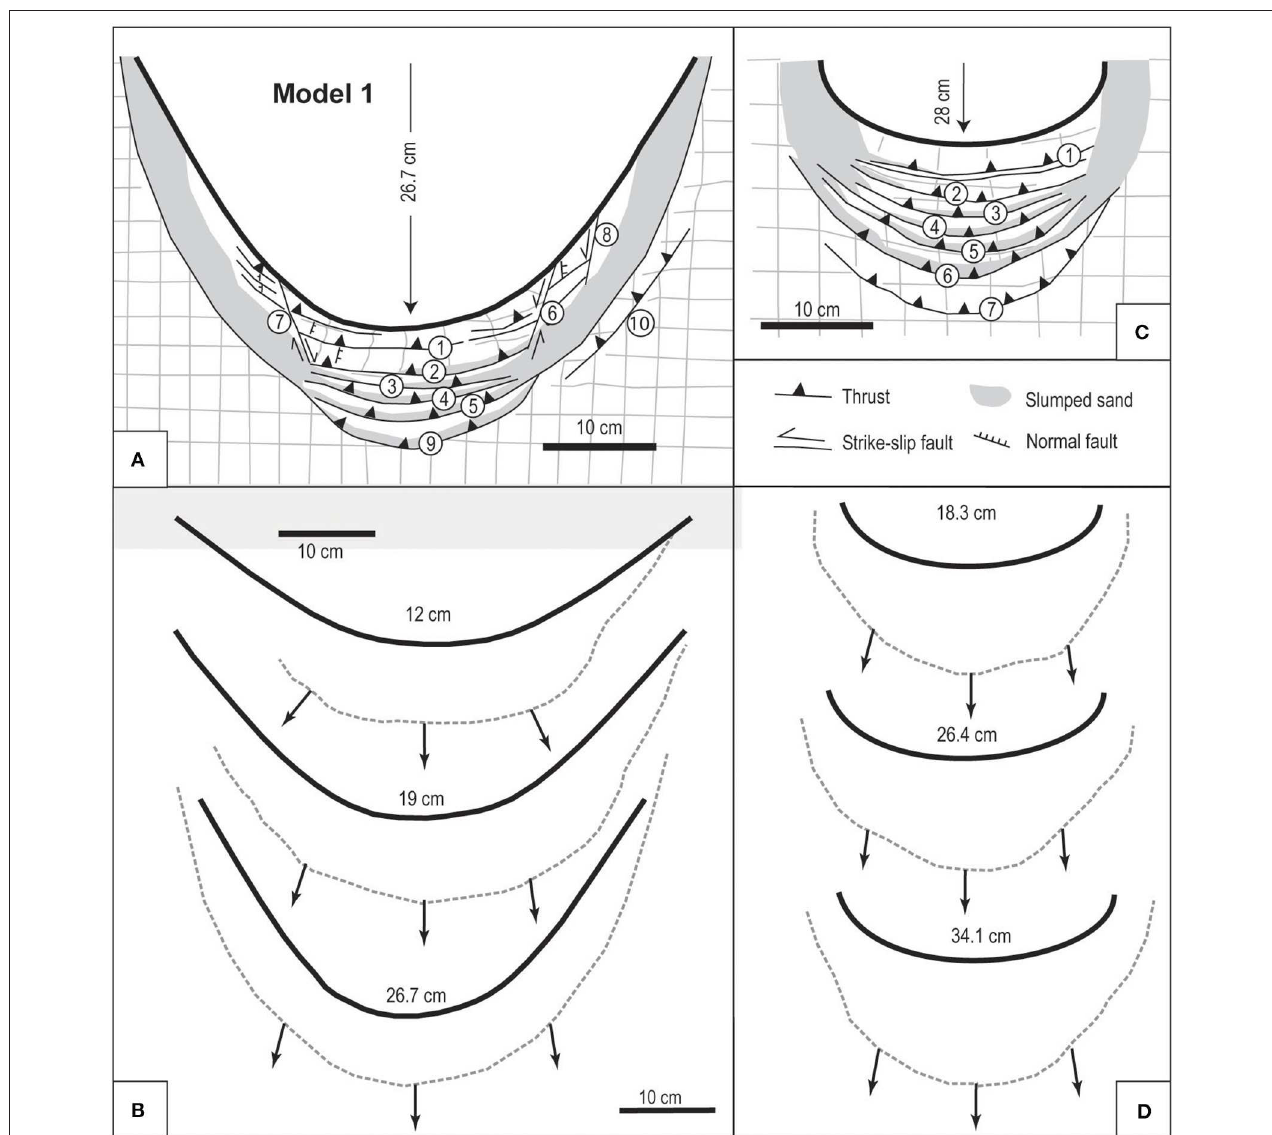
FIGURE 3 | Line drawings of experiments with an initial sandpack: (A) Model 1: final stage. The numbering indicates the chronology of the structures. (B) Model 1: progressive displacement of the frontal thrust (dashed line) for various positions of the indenter (numbers: apex movement) and displacement vectors along this thrust (arrows). (C,D) idem (B,C) , respectively, from a model of Crespo-Blanc and González-Sánchez (2005) with a rigid